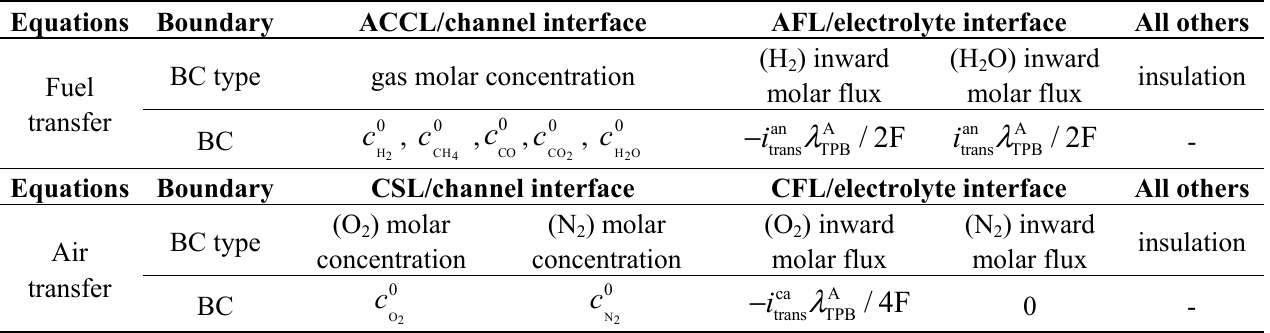
Table 1. Boundary settings for mass transports in electrodes. “Insulation” means no flux through the boundary.